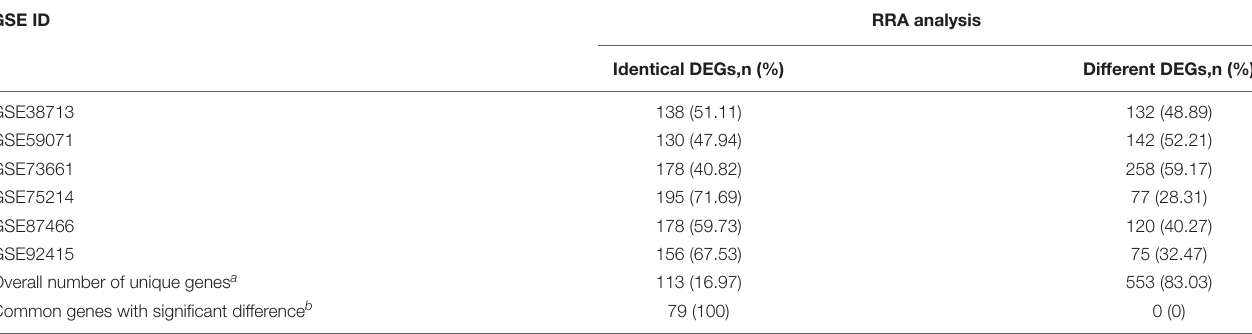
TABLE 3 | Comparison of DEGs identified by single dataset analysis and RRA integrated